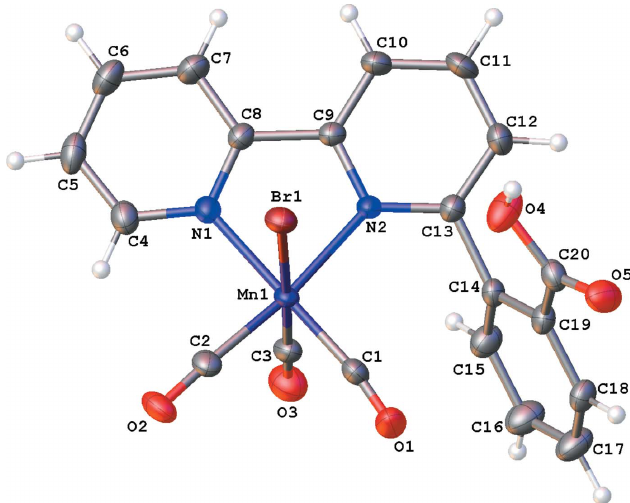
Figure 3 The molecular structure of compound I , with atom labeling and showing the position of the major component of the disordered benzoic acid group. Displacement ellipsoids are drawn at the 50% probability